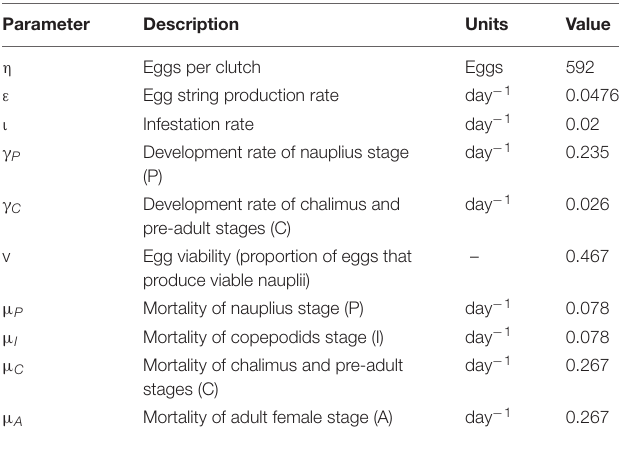
TABLE 1 | Key parameters in the ordinary differential equation (ODE) model of sea lice dynamics. Parameter